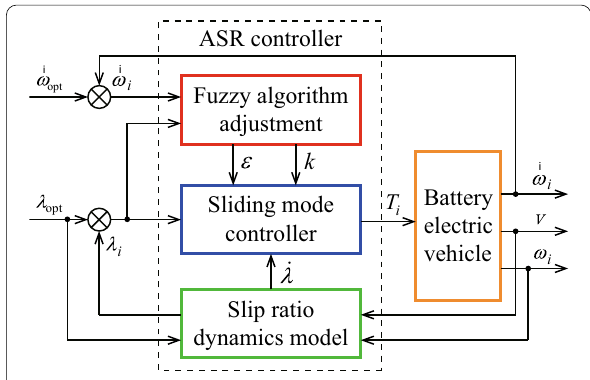
Figure 4 Architecture of sliding mode control